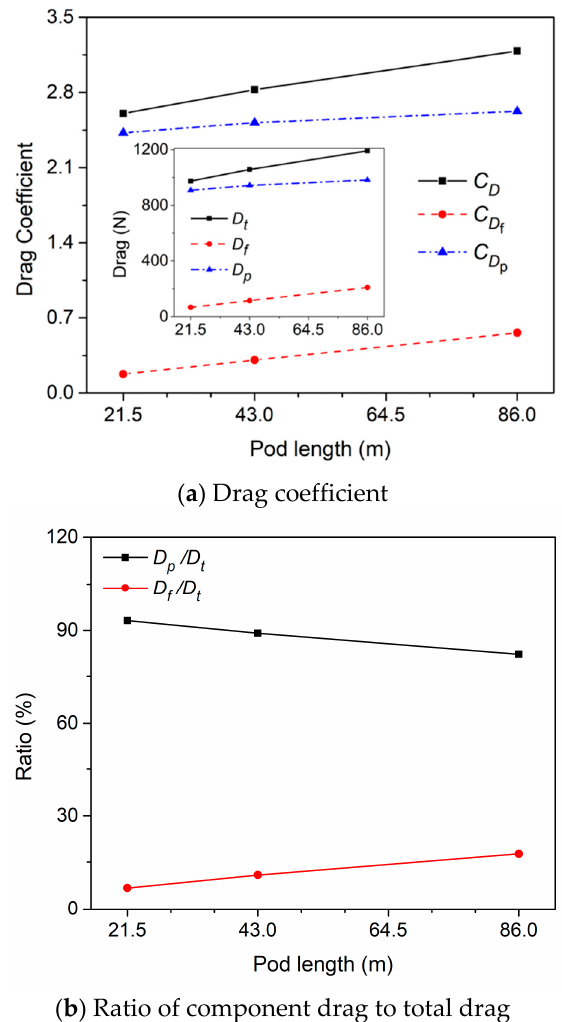
Figure 11. Effect of pod length: ( a ) Variation of drag and drag coefficient with respect to pod length. Figure 11. E ff ect of pod length: ( a ) Variation of drag and drag coe ffi cient with respect to pod length. The results are similar to those of the steady state study by Oh et al., (2019) [5] (the difference is below The results are similar to those of the steady state study by Oh et al. (2019) [5] (the di ff erence is below 17%). ( b ) Ratio of pressure and friction drag to total drag. 17%). ( b ) Ratio of pressure and friction drag to total